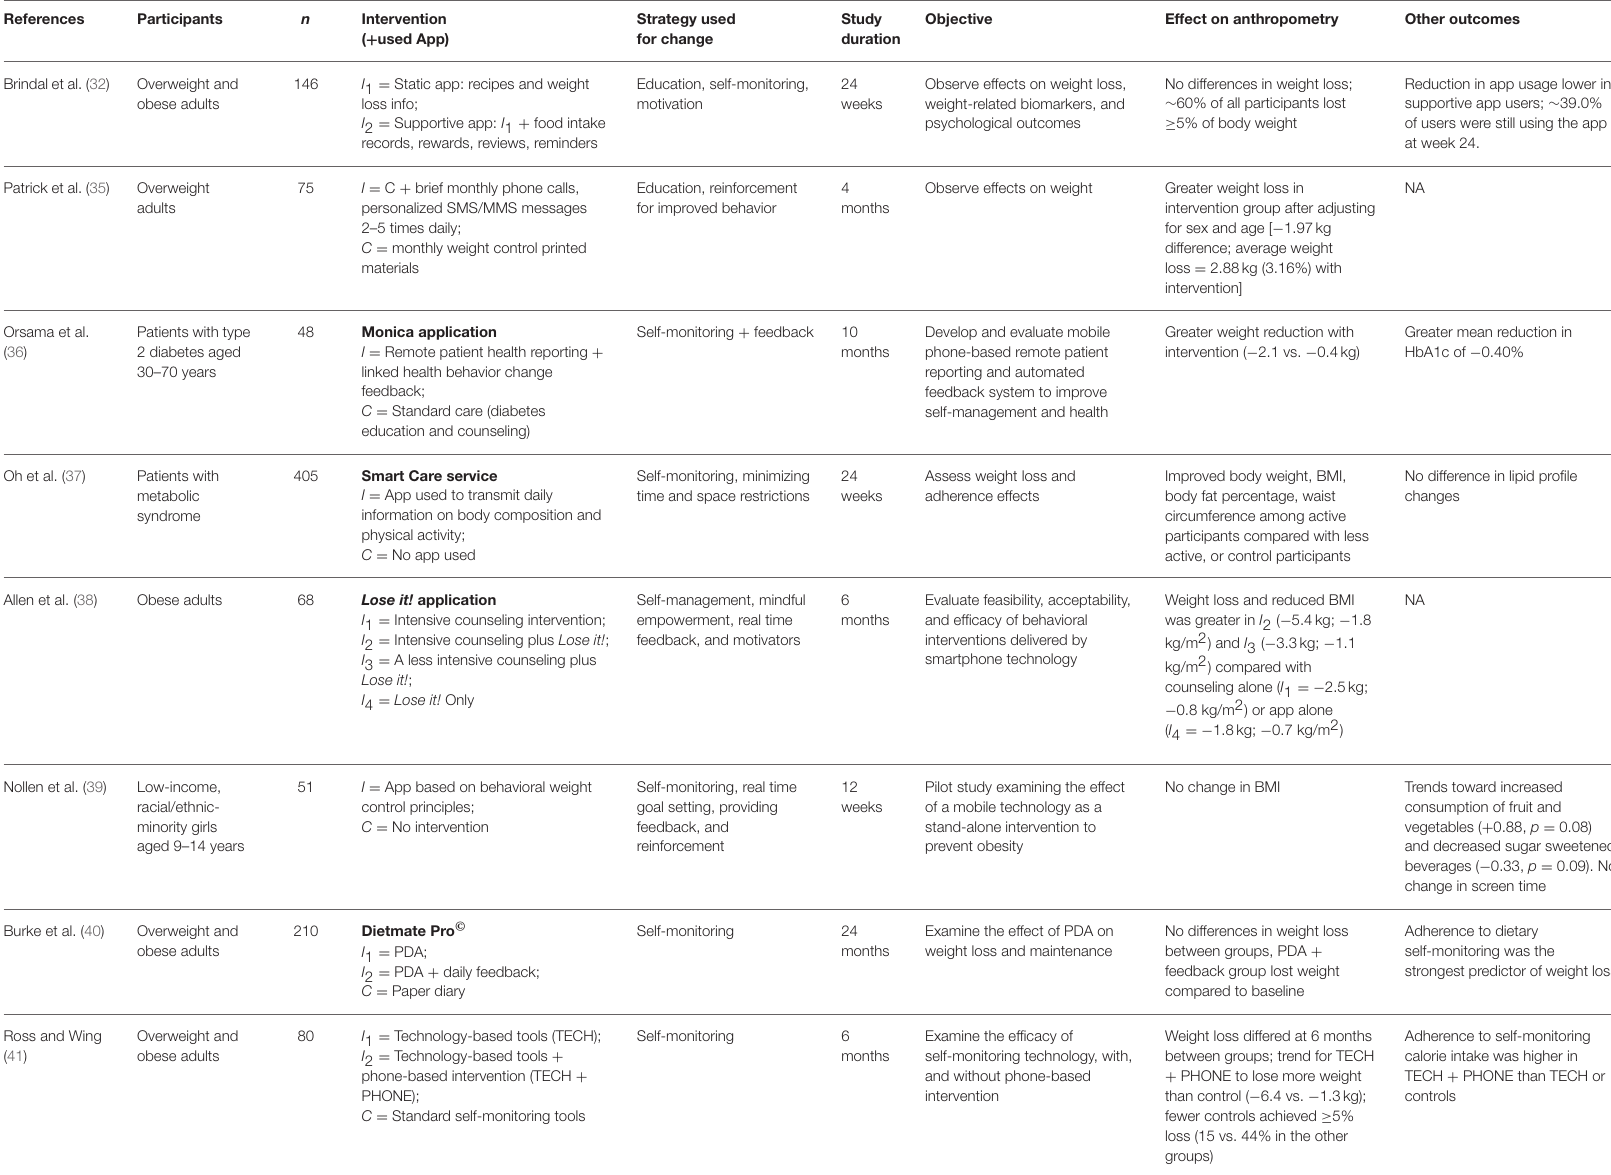
TABLE 1 | Characteristics and outcomes of randomized clinical trials examining the usefulness of mobile apps in weight